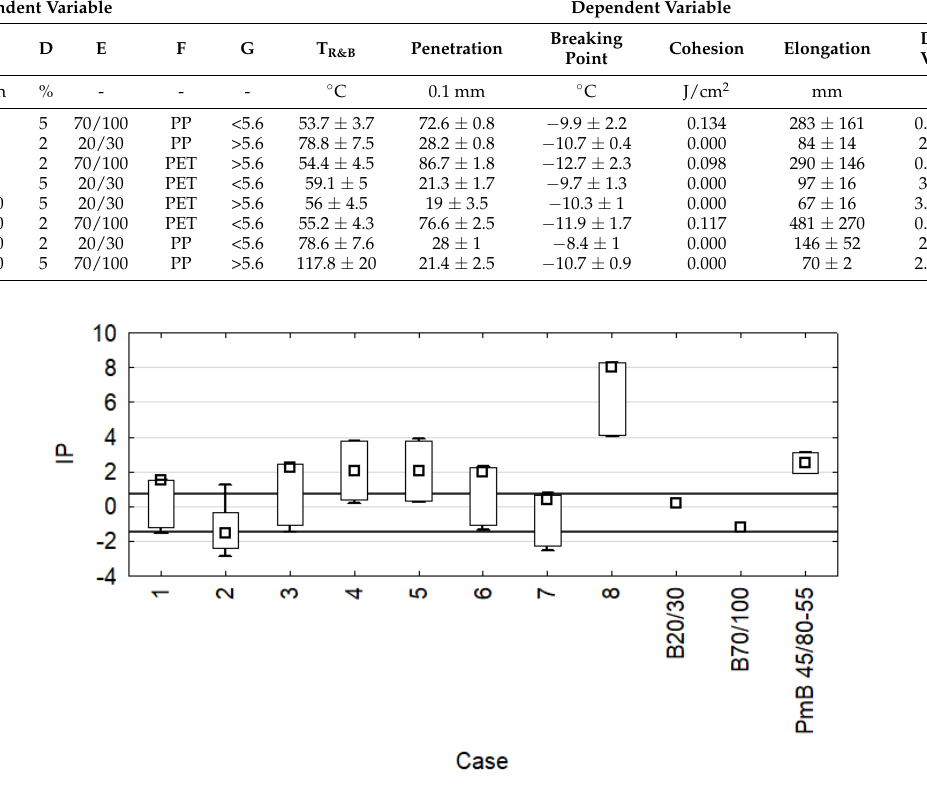
Table 4. Results of modified bitumen properties designation based on the Plackett–Burman design.